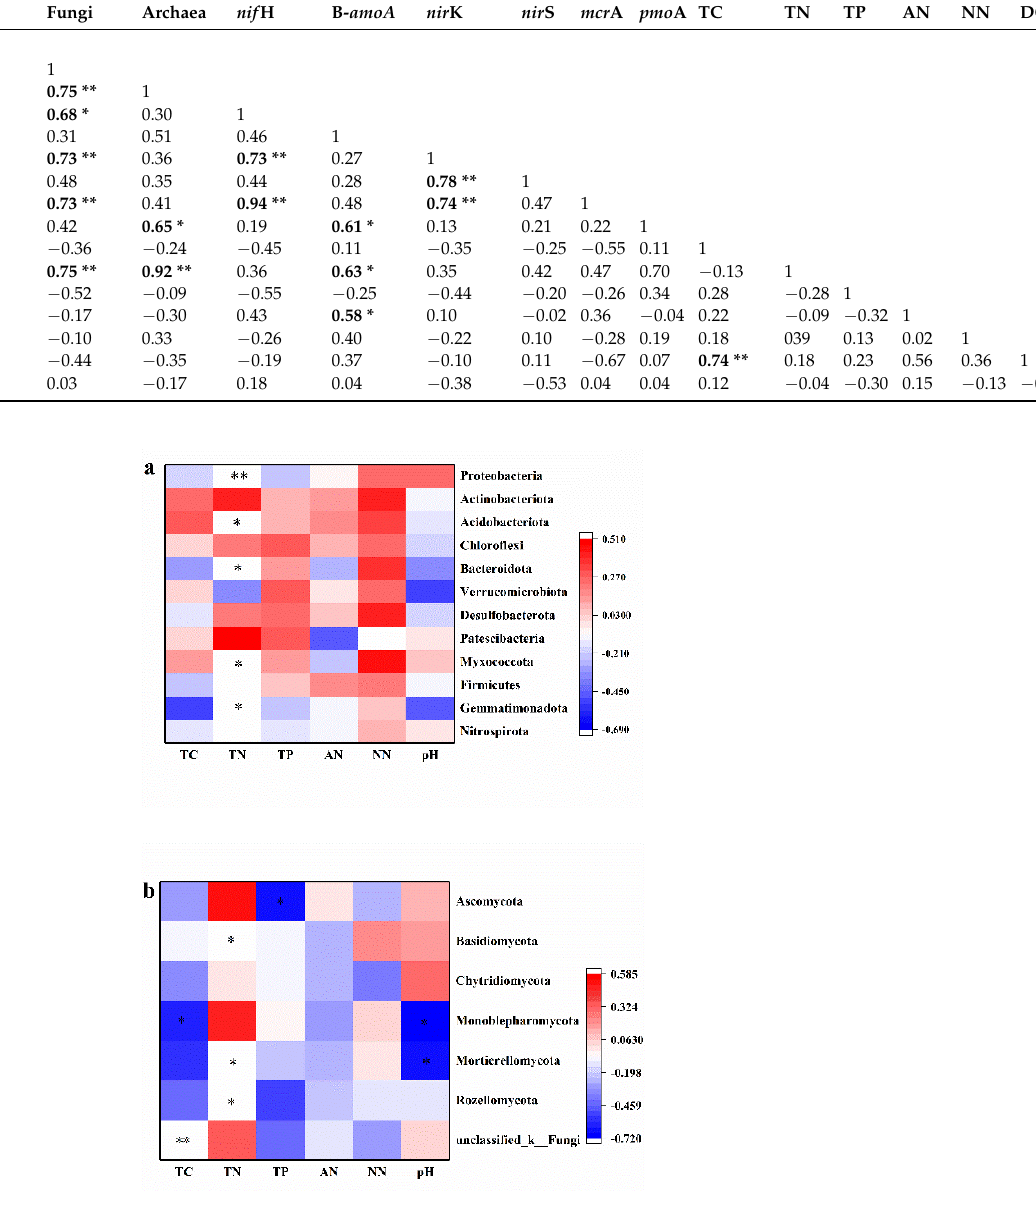
Figure 7. Correlation analysis of soil microbial relative abundance at ( a ) bacteria and ( b ) fungi phyla level and soil chemical properties under nitrogen addition. * significant at 0.05 level, ** significant at 0.01 level.